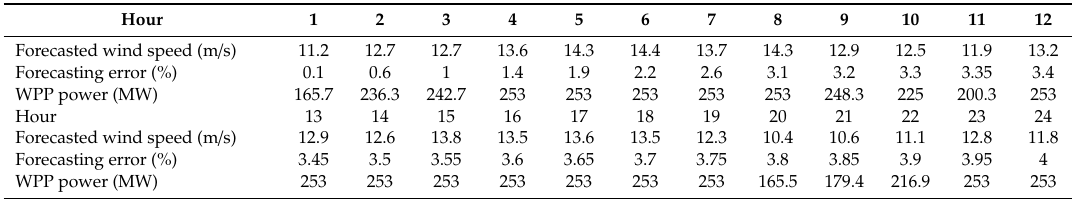
Table 2. Wind speed forecast together with the associated uncertainty. WPP—wind power plant.